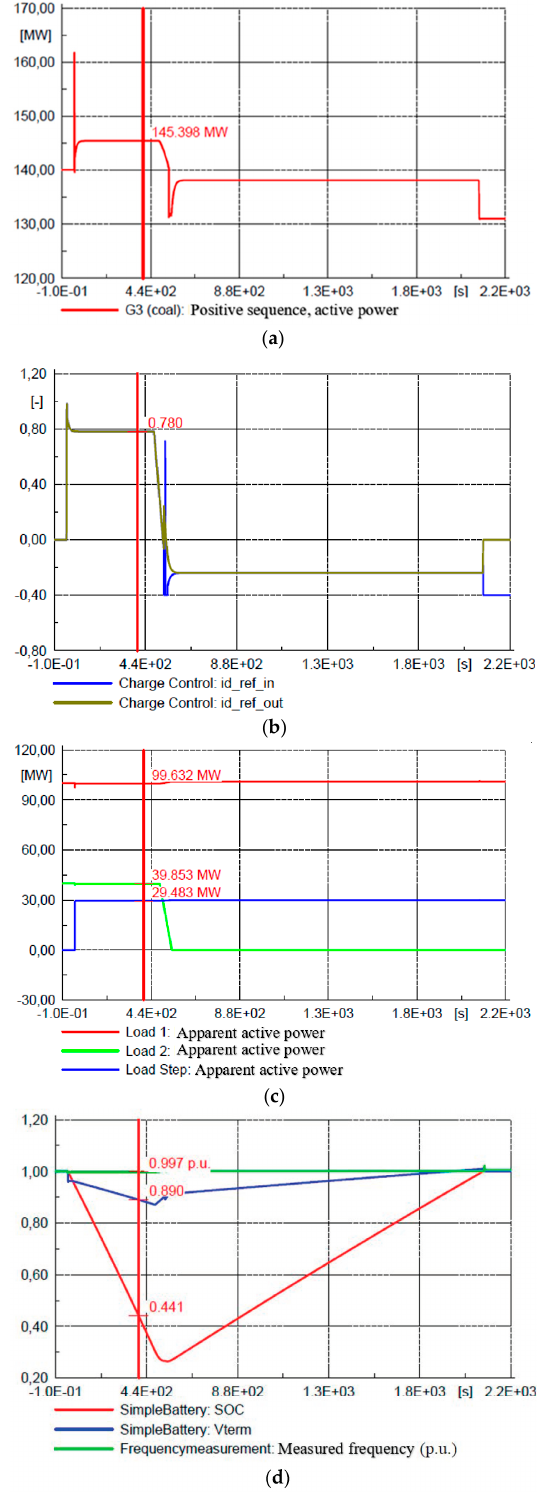
Figure 5. The results of test studies of the SNE when the network load changes. ( a ) Active load schedule of generator G3, taking into account the influence of the ESS. ( b ) ESS battery charge charts. ( c ) Timing diagram for load initation and end in the network. ( d ) Change in the capacity and voltage of the ESS batteries over time. In order to cover as many options as possible and see the influence of ESS on the most general case, we simulated a network with the most typical parameters and generation and load power values. At the same time, the average total load power was about 140 MW and the power of the ESS inverter was 30 MW, which is comparable to the magnitude of